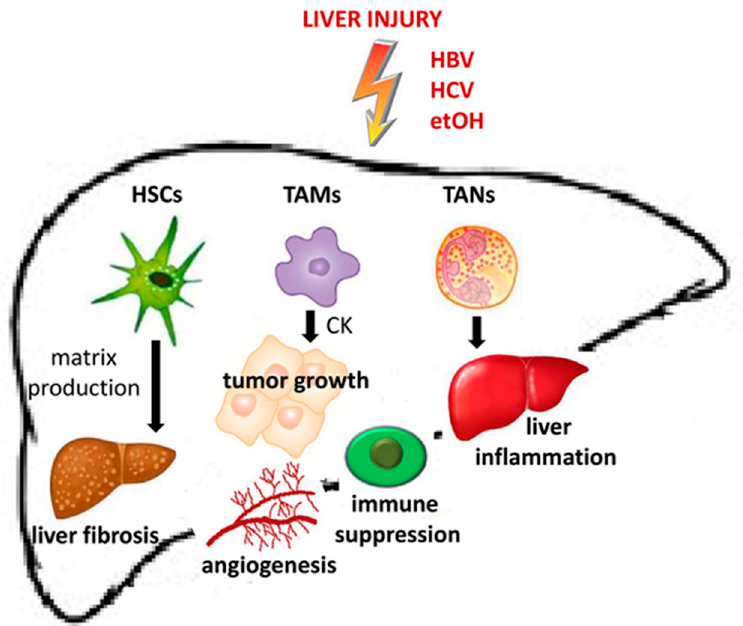
Figure 1. Role of stromal cells in the realization of premalignant microenvironment and HCC onset. HSCs (Hepatic Stellate Cells), TAMs (Tumor Associated Macrophages) and TANs (Tumor Associated Neutrophils) contribute respectively to induce liver fibrosis by matrix production, to promote tumor growth prompting the angiogenesis process and immune suppression leading to liver inflammation.